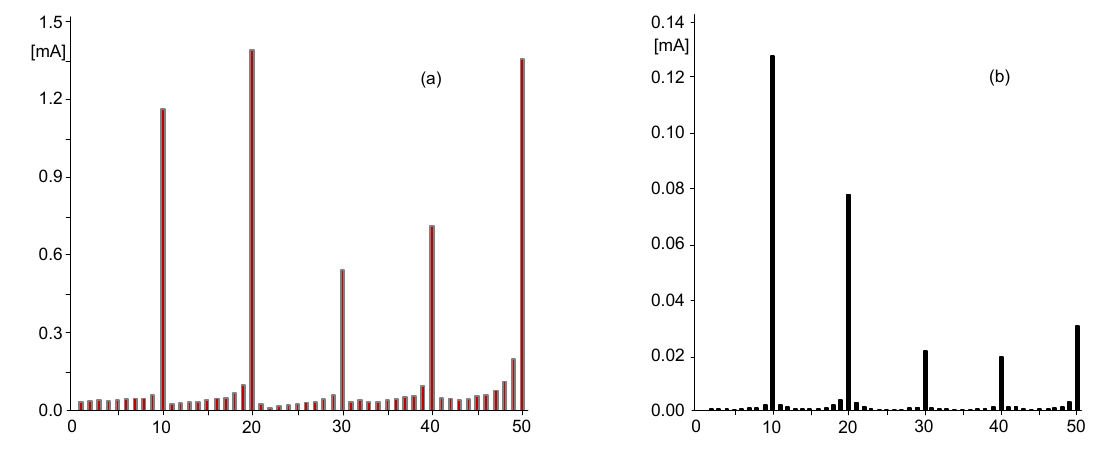
current spectrum with filter. 1